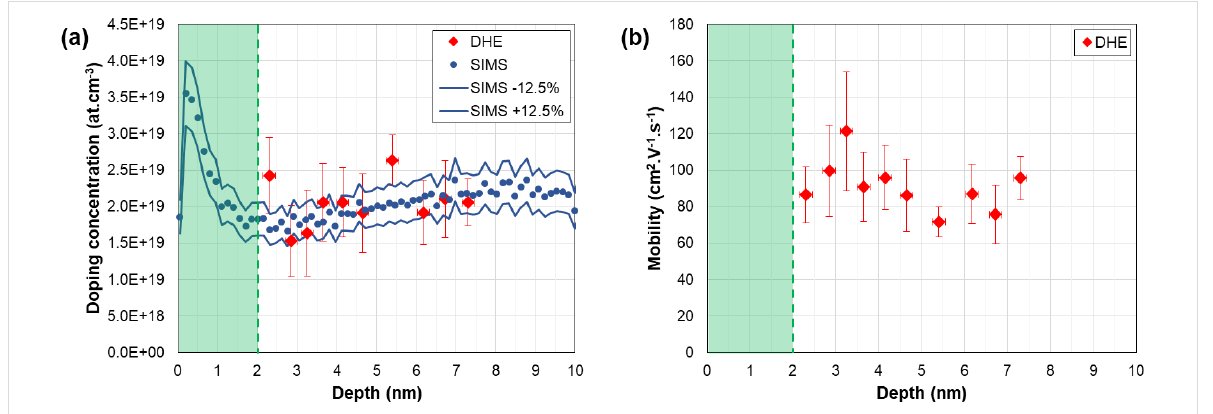
Figure 4: Depth profiles of (a) active dopant concentration and (b) carrier mobility extracted from the DHE measurements of Si 0.77 Ge 0.23 uniformly boron-doped at 10 19 cm − 3 . In panel (a), the active dopant concentration profile is compared to the chemical boron concentration profile measured with SIMS. Green areas are depletion